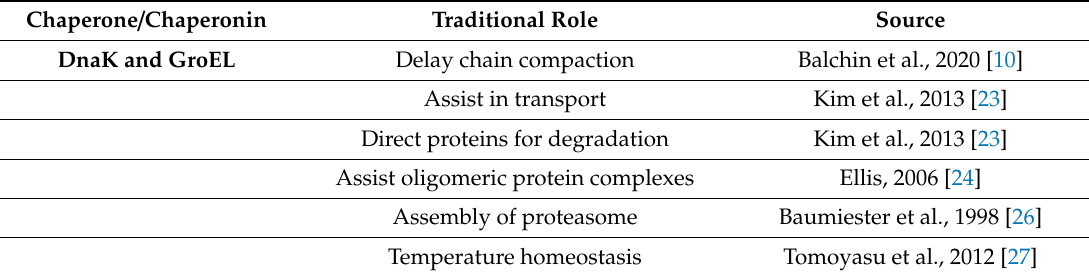
Table 1. Traditional and non-traditional roles of DnaK and